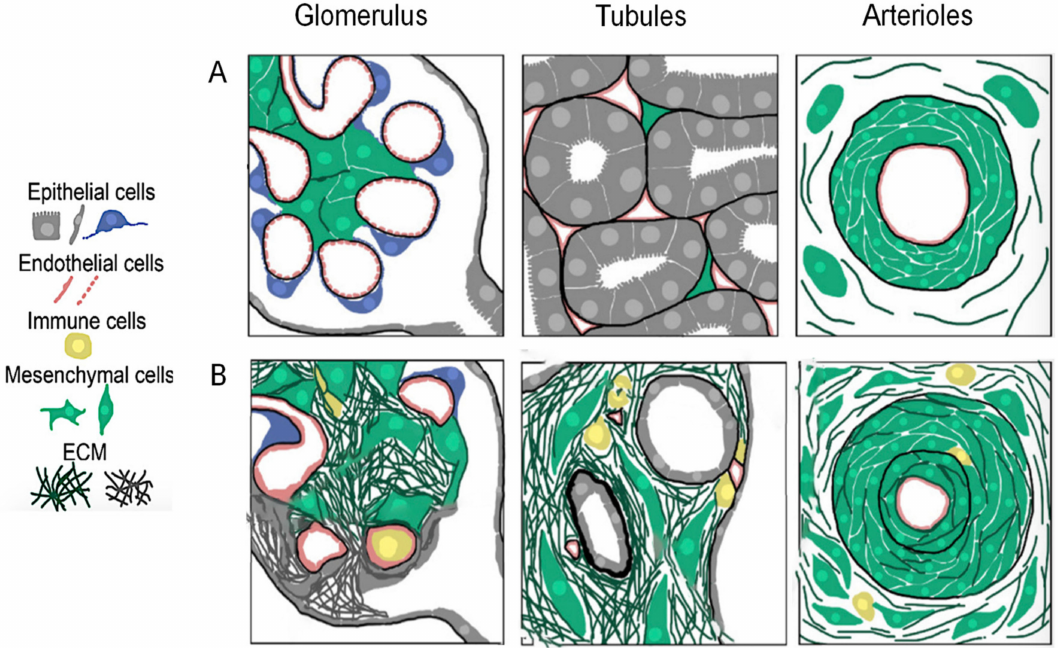
Figure 1. Schematic diagram showing the structural transition from ( A ) healthy to ( B ) fibrotic kidneys. The continued insult to the tissue leads to prolonged infiltration of immune cells and persistent activation and differentiation of myofibroblasts (mesenchymal cells), resulting in excessive collagen deposition within the glomerulus, renal tubules, and vasculature, which disrupts normal kidney architecture. These structural abnormalities drive progressive cell death and irreversible loss of kidney functions. Figure adapted from